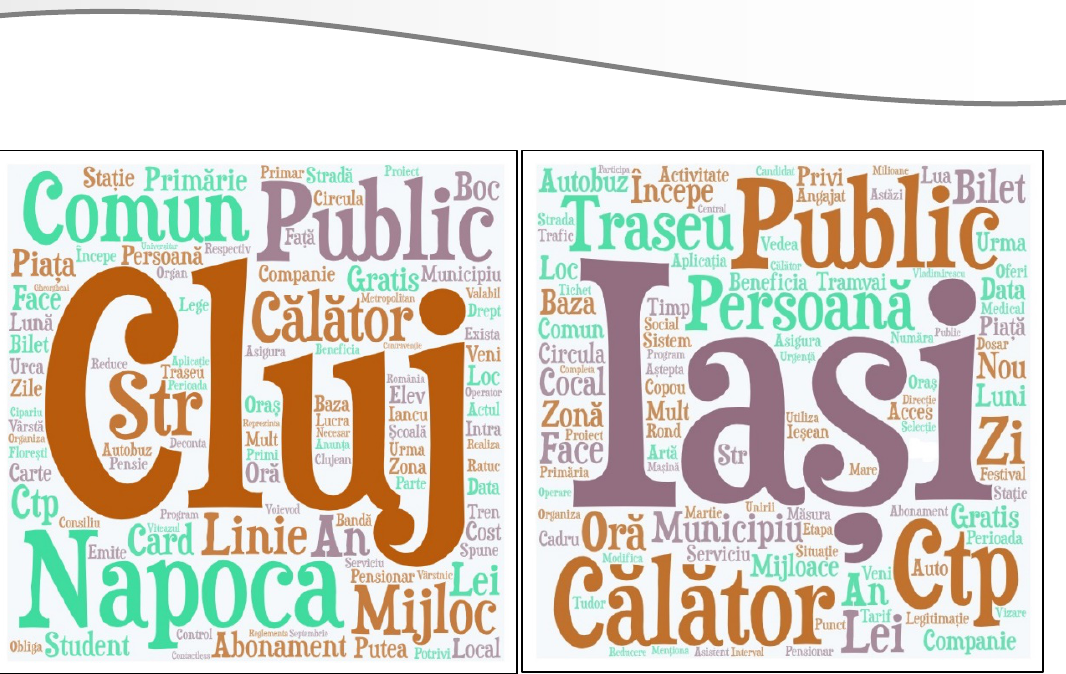
Figure 10: Most frequent 100 words in the case of Cluj - Napoca and Iași respectively